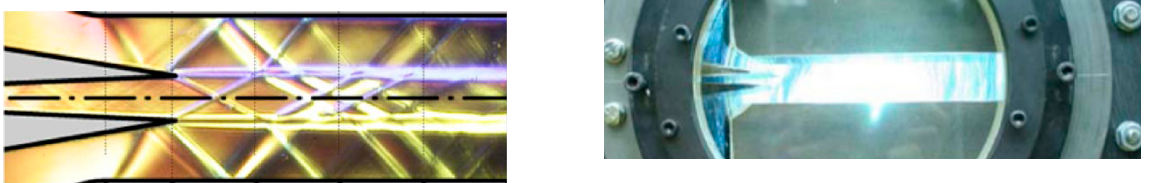
Figure 27. Example of color Schlieren out of supersonic nozzle in an air-to-air ejector ( left ), experimental apparatus ( right ). Reprinted with permission from Ref. [44] (2013).